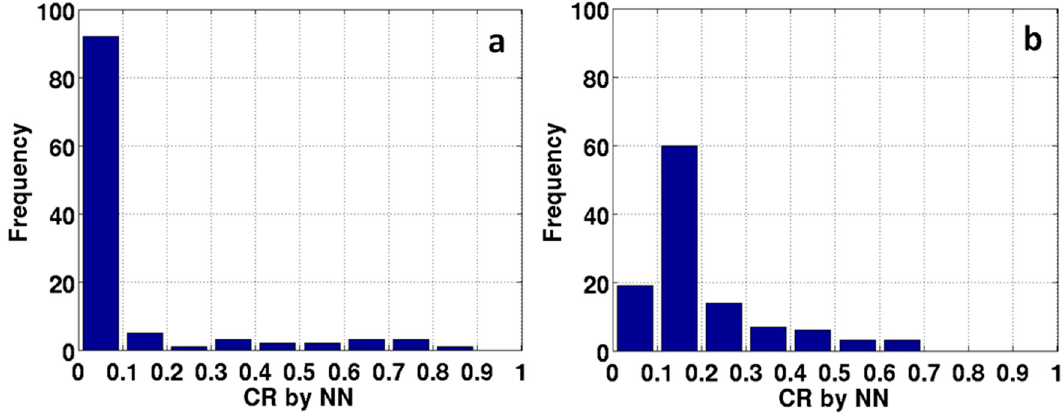
Figure 6. NN Collapse Ratio estimated after the M6.0 earthquake on 24 August 2016. ( a ) NN approach using optical inputs and ( b ) optical and SAR.